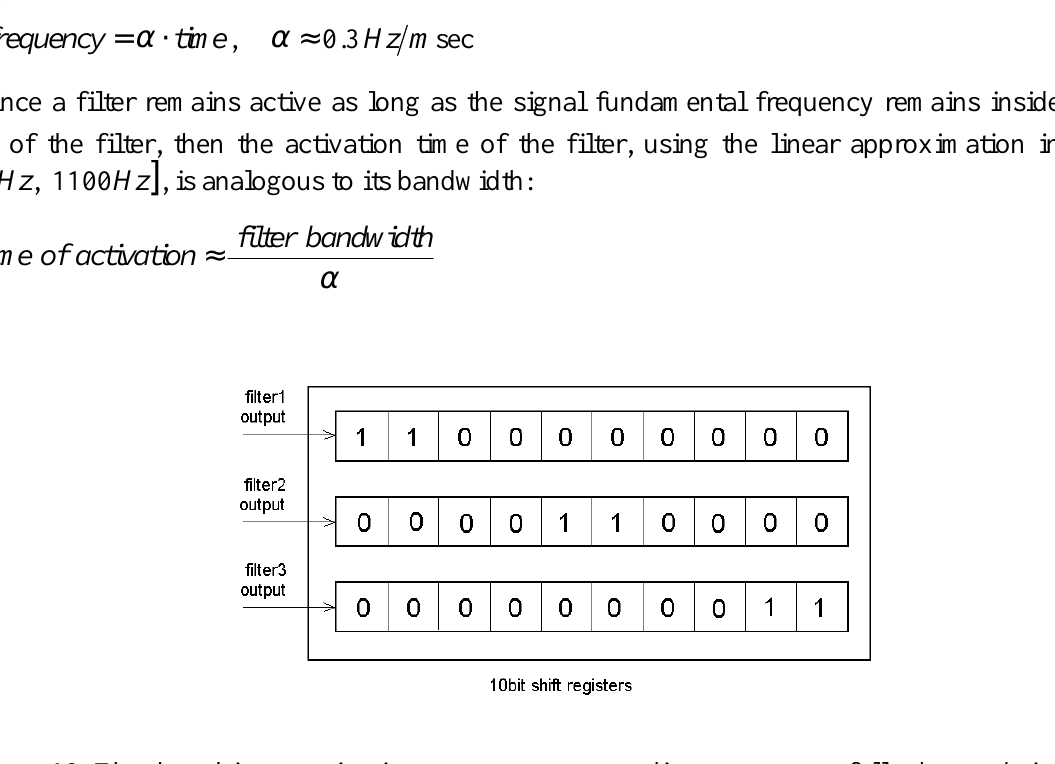
Figure 10. The three binary activation patterns corresponding to a successfully detected siren signal. If the center frequencies of the filters are set to 700Hz, 900Hz and 1100 Hz, and the pulse rate of the clock is determined to 7 pulses/sec, then the recording of each filter output for a time distance: sec5.1